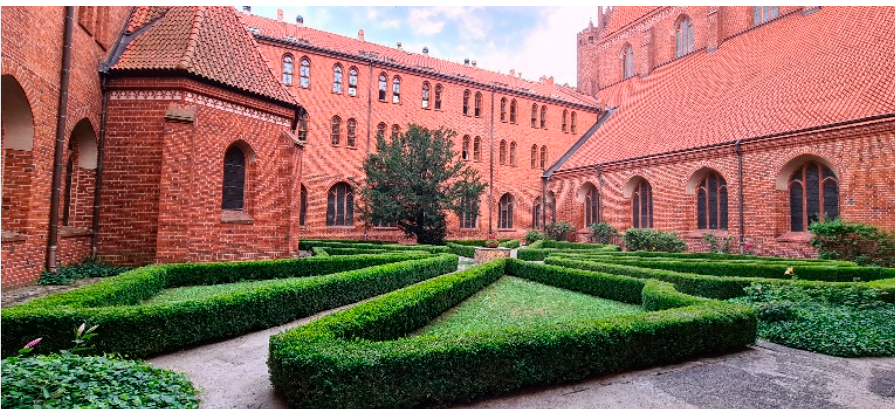
Figure 4. The buildings of the Cistercian abbey in Pelplin—outer view. Figure 5 shows a horizontal top view of the 15th-century Cistercian abbey